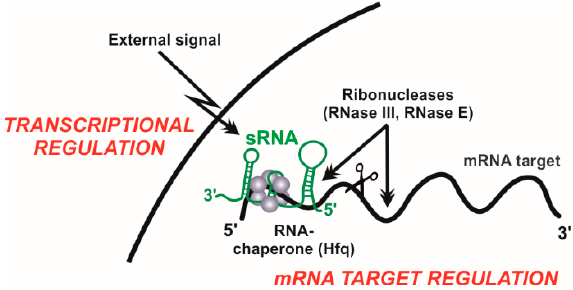
Figure 2. Key features of bacterial trans -sRNA biology. Differential regulation, target recognition and association with RNA chaperones and ribonucleases.